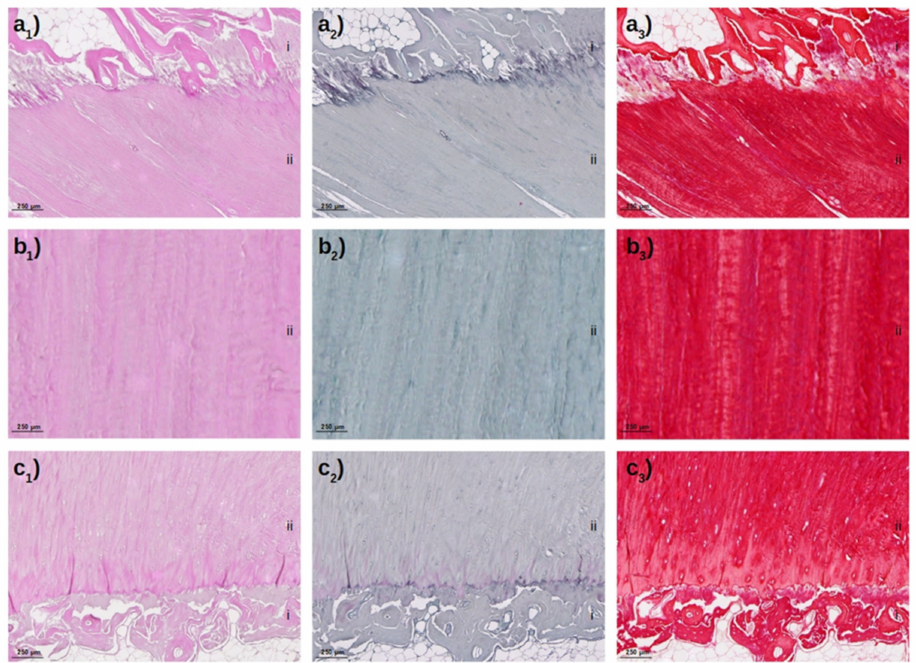
Figure 3. Microscopic reference evaluation of the posterior cruciate ligament (PCL). Displayed are close-up views of the femoral ( a 1 – a 3 ) insertion sites, the ligamentous portion ( b 1 – b 3 ), and the tibial insertion site ( c 1 – c 3 ) of a representative PCL following hematoxylin and eosin ( a 1 , b 1 , c 1 ), Safranin O ( a 2 , b 2 , c 2 ), and Picrosirius red staining ( a 3 , b 3 , c 3 ). The PCL insertion sites are intact with regular bone and calcified fibrocartilage (i) and ligament (ii). In this specimen and throughout, fibers were oriented parallel without any fiber discontinuity. Other magnifications indicated the absence of relevant thickening or thinning and degenerative changes (not shown). Bars correspond to 250 µ